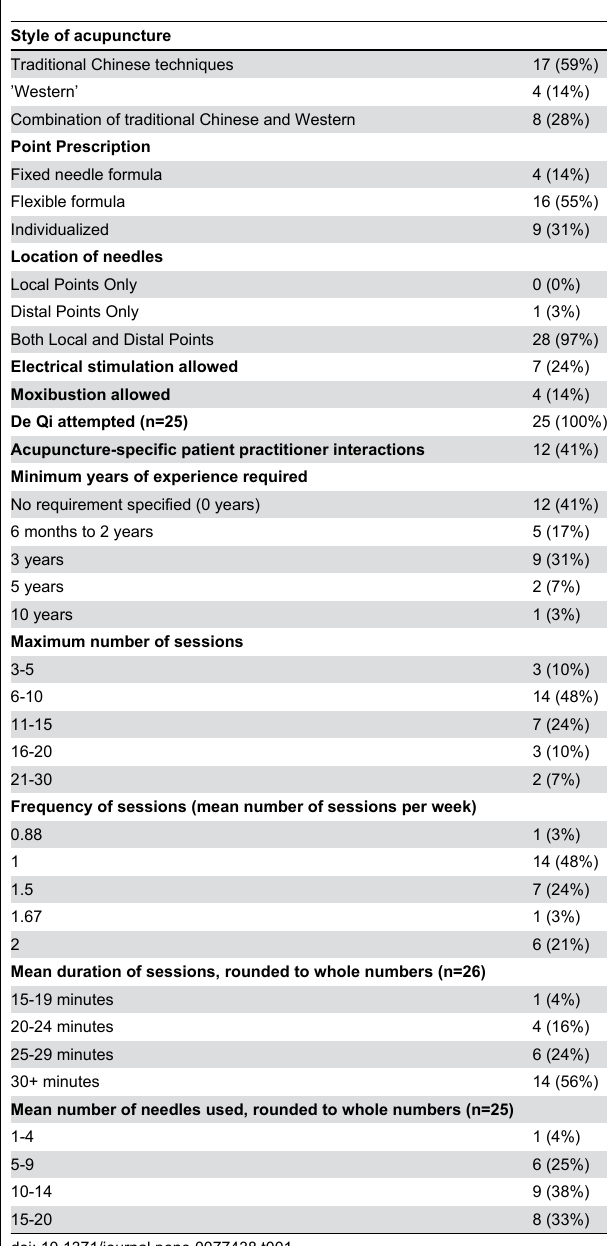
Table 1. Trial-level acupuncture characteristics. Frequency (%).